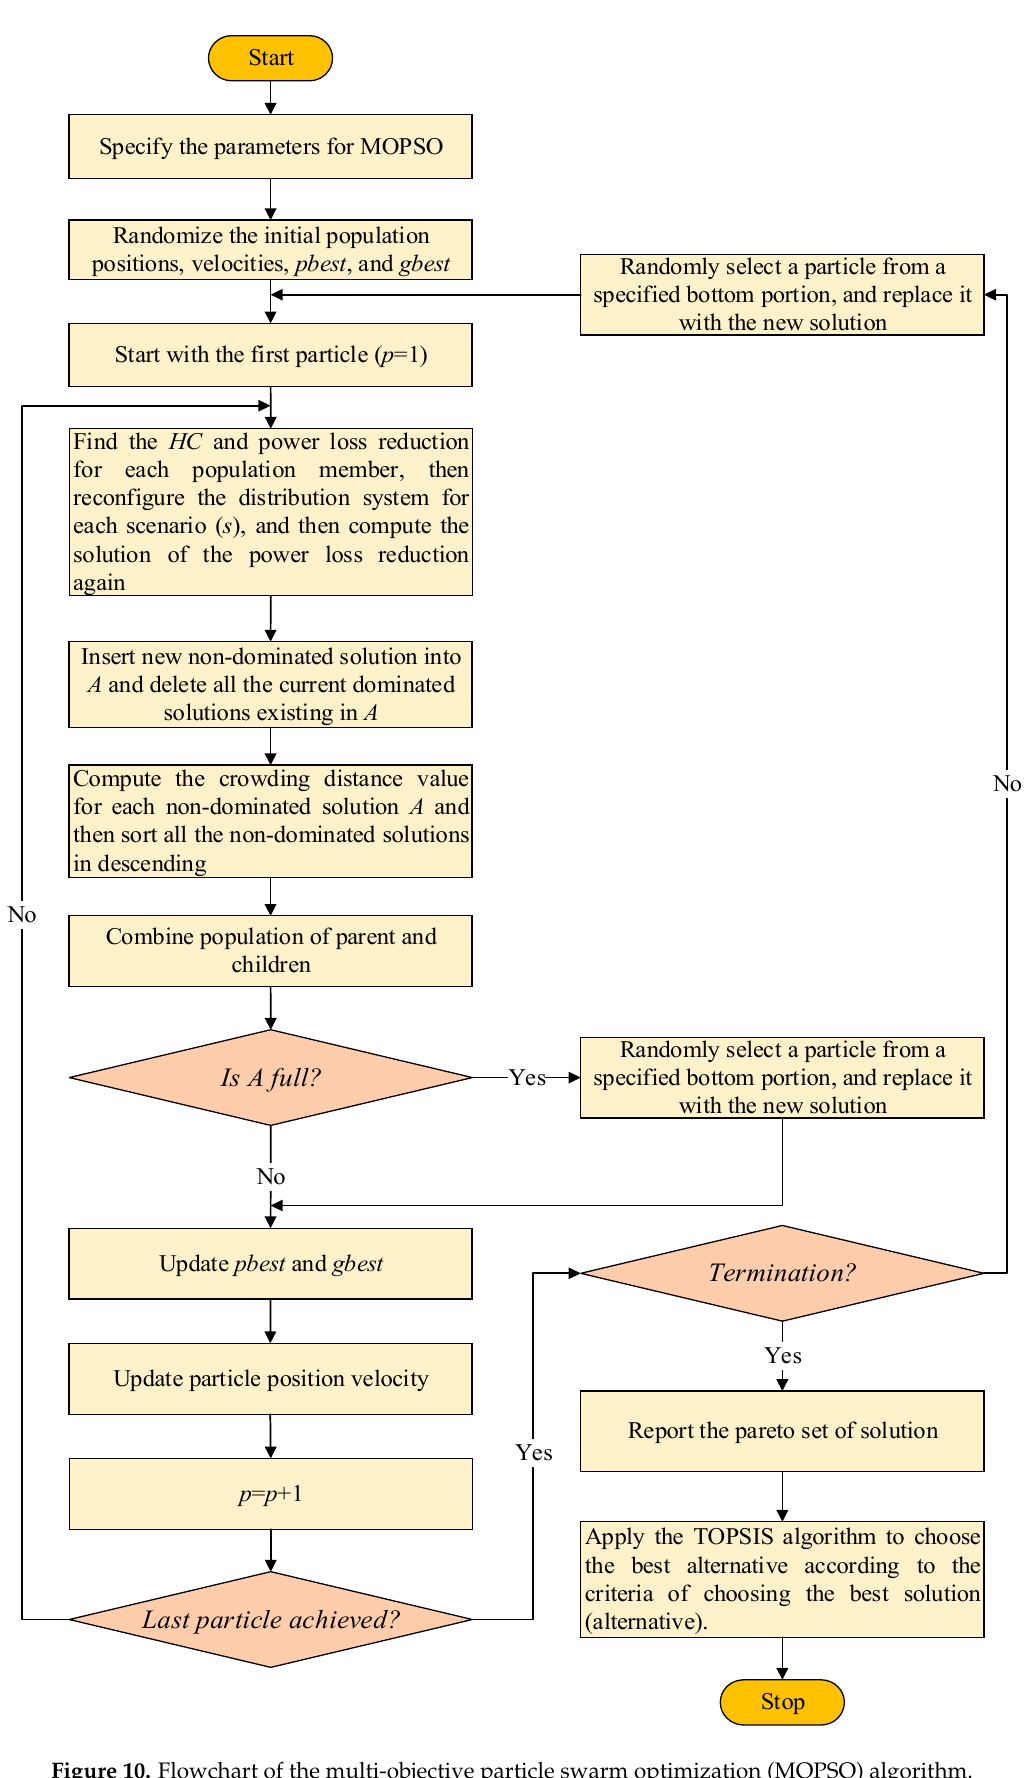
Figure 10. Flowchart of the multi-objective particle swarm optimization (MOPSO) algorithm.